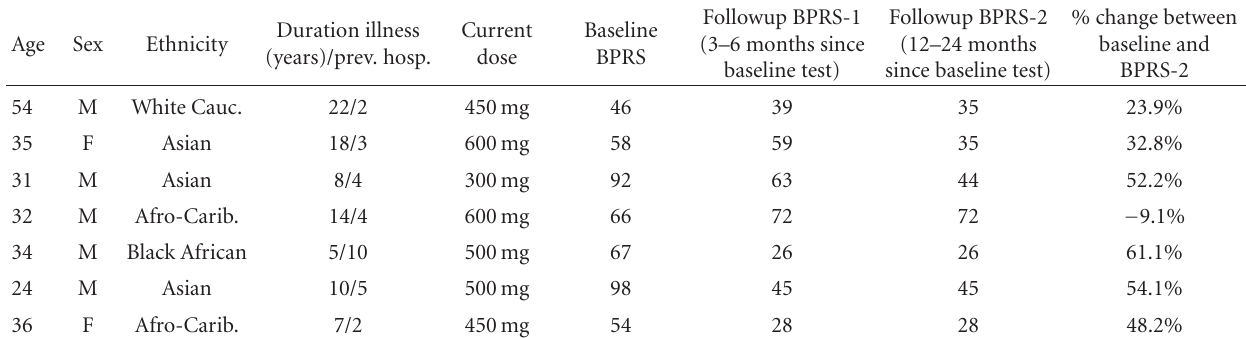
Table 2: Those 7 patients who are currently continuing with